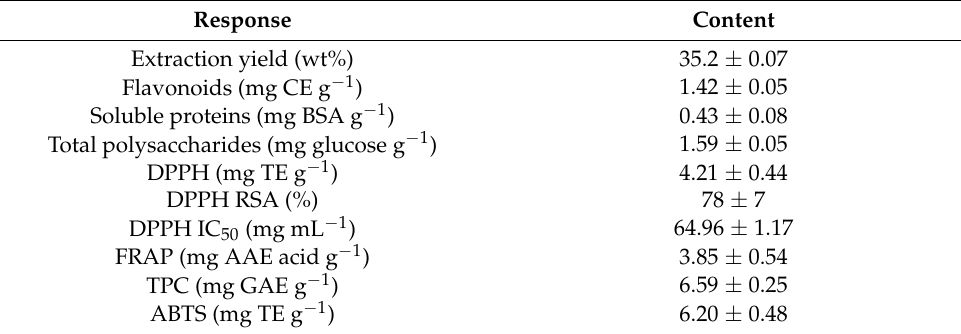
Table 3. Chemical characterization of ASE obtained under MAE optimal conditions (57 min, 80 ◦ C, pH 8, and 70% ( v / v ) ethanol), expressed per gram of AS